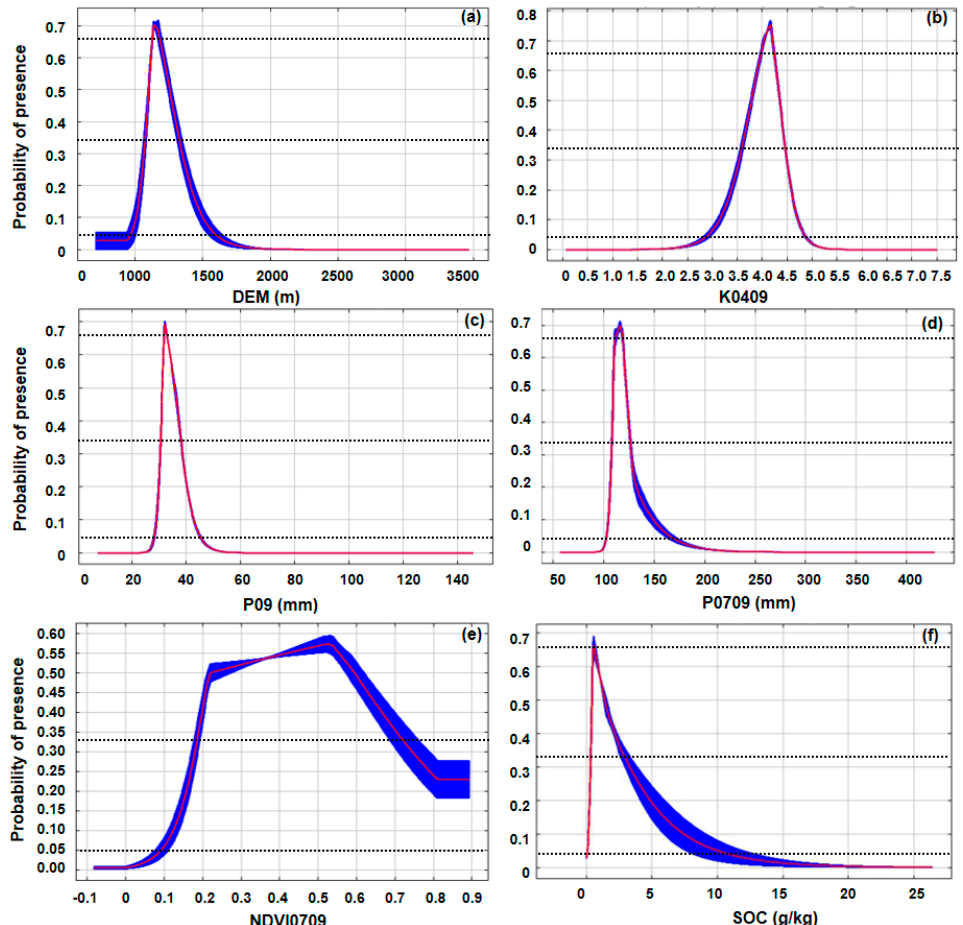
Figure 5. Response curves of dominant environment variables (DEM ( a ), K0409 ( b ), P09 ( c ), P0709 ( d ), NDVI0709 ( e ), SOC ( f )) in the MaxEnt model. Note: response curves showed the relationships between existence probability of wine grape and six environment variables. Blue line represents the standard deviation (SD) of 10 replicates and red line represents mean value. DEM represents altitude. K0409 represents aridity index from April to September. NDVI0709 represents NDVI from July to September. P0709 and P09 represent total precipitation from July to September and in September. SOC represents soil organic carbon.